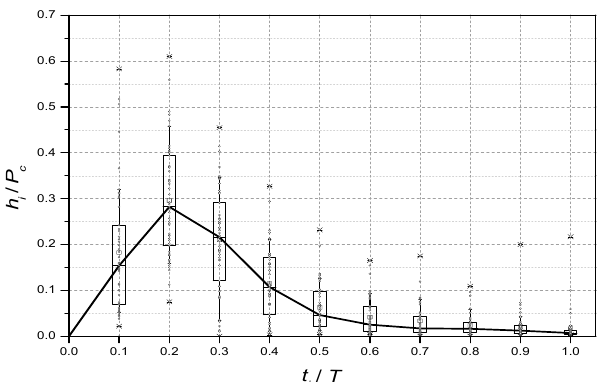
Figure 5. Dimensionless hyetograph of interval increments of 51 precipitation, with box charts of measurement results for Wrocław.